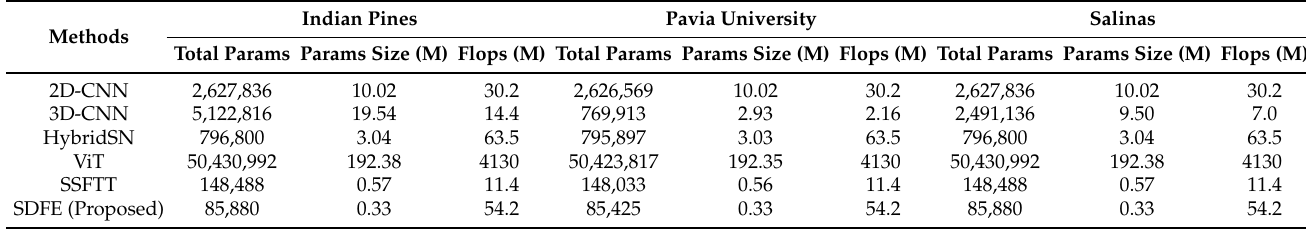
Table 14. The memory consumption of the SDFE method and other baseline methods (the Unit M represents million